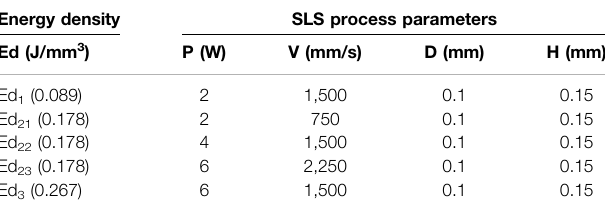
TABLE 4 | Main SLS process parameters of PCL scaffolds in this study. Energy density SLS process